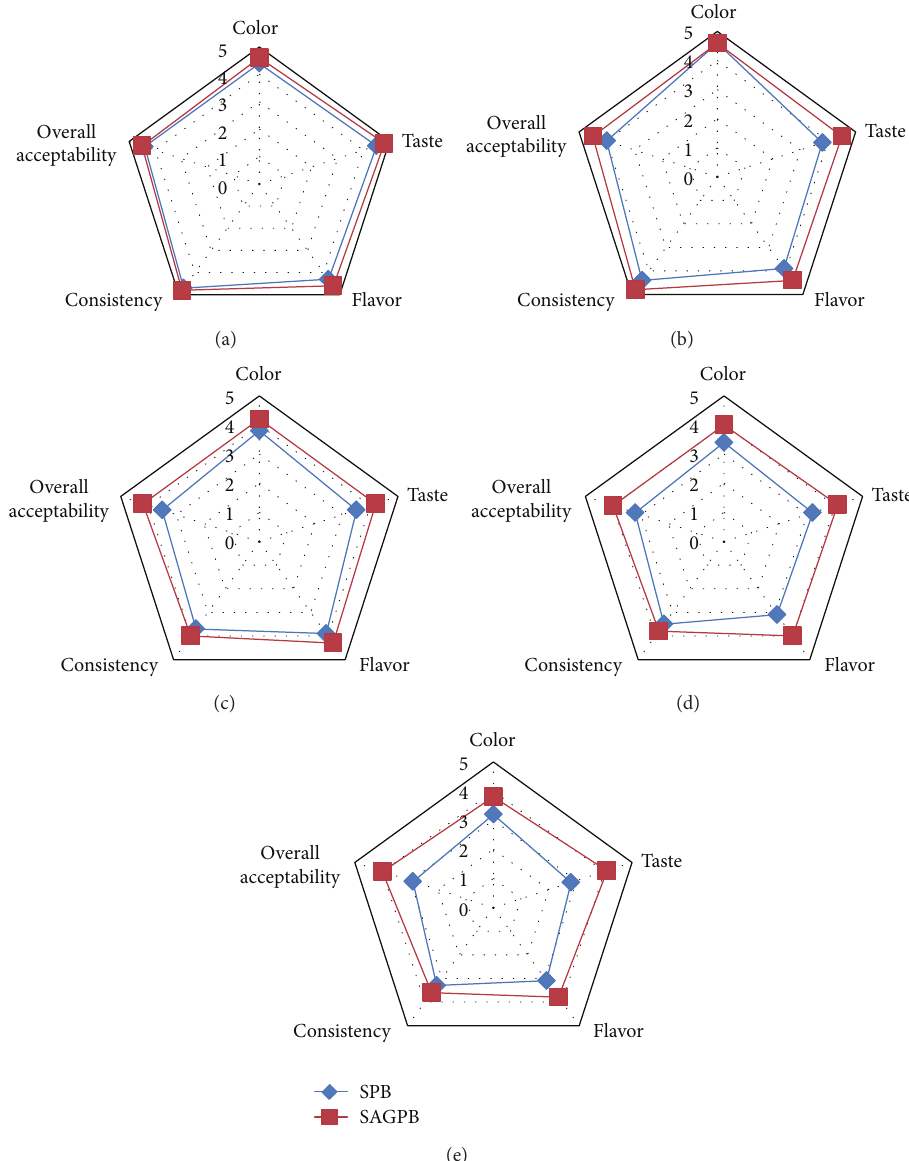
Figure 1: Sensory acceptability of the developed beverages—SPB (spiced papaya beverage) and SAGPB (spiced Aloe gel-papaya beverage blend) after 0d (a), 45 d (b), 90 d (c), 120 d (d), and 150 d (e) of